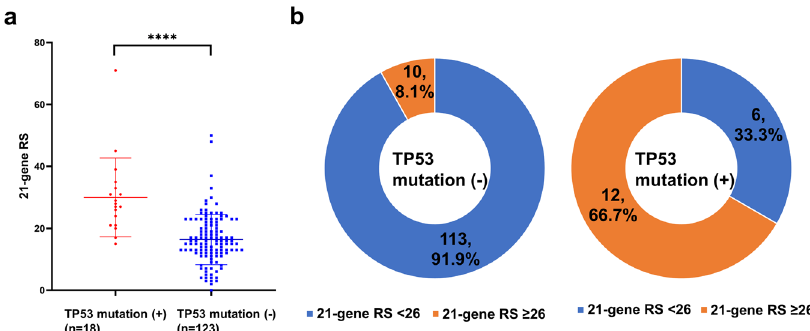
Fig. 2 Association between TP53 mutation and Oncotype DX ® recurrence scores (RSs). a Mean Oncotype DX ® RS according to mutated TP53 compared using Student ’ s t -tests ( p < 0.001). Error bars correspond to standard error of the mean. b Distribution of Oncotype DX ® risk group compared based on TP53 mutation using Fisher ’ s exact tests ( p = 0.021). Oncotype DX ® RS ≥ 26 indicates high risk. Table 2. Binary logistic regression analysis of factors associated with high ( ≥ 26) Oncotype DX ® recurrence score.